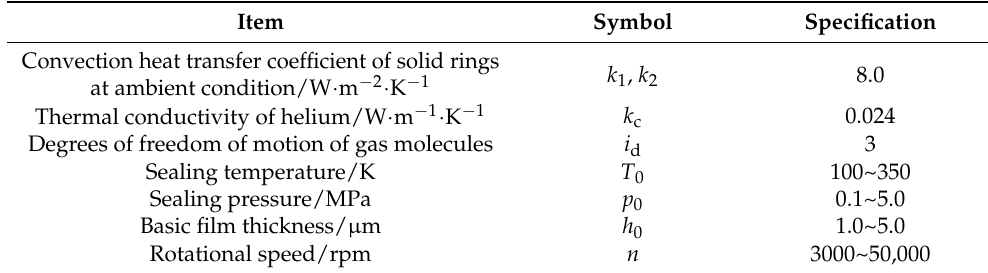
Table 3. Themo-hydrodynamic parameters used in the theoretical calculations [35]. Item Symbol